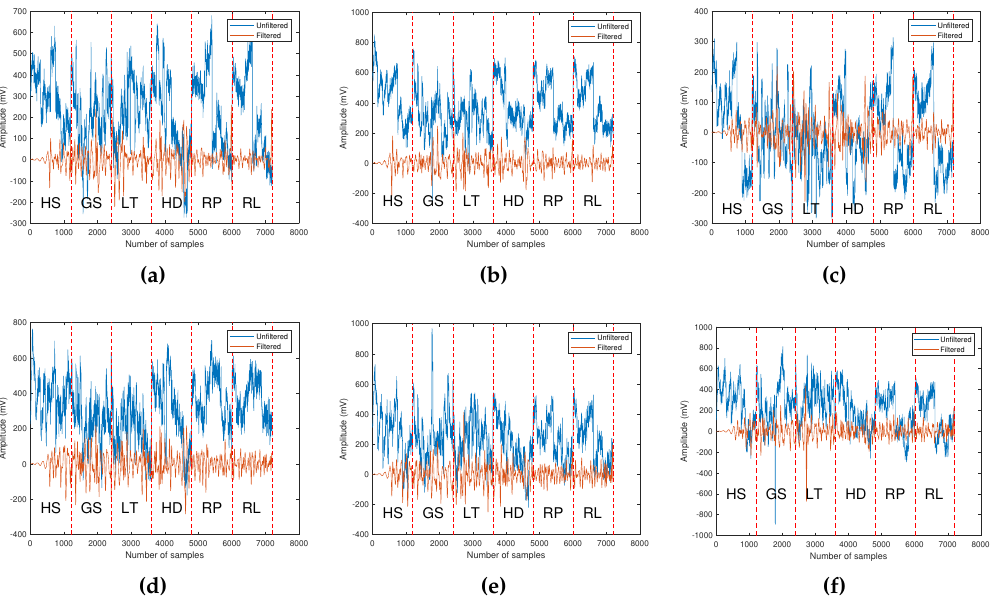
Figure 6. The 14.4 s duration of the original and band pass filtered EEG recordings for subject 1 from electrode ( a ) C3, ( b ) Cz, ( c ) C4, ( d ) P3, ( e ) Pz, and ( f ) P4, comprising the six grasp-and-lift motor events, HS, GS, LT, HD, RP and